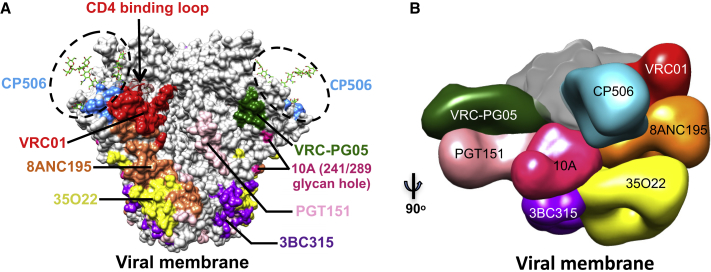
CP506 Lineage Antibody Epitopes on the Env Trimer(A) Epitopes of the CP506-lineage antibodies, representative bNAbs, and 241/289 glycan hole targeting mAb 10A on the BG505 SOSIP.664 trimer surface (PDB: 4TVP), with a side view of two protomers shown.(B) Binding site comparison of CP506 to selected bNAbs and 241/289 glycan hole targeting mAb 10A on 3D EM reconstruction in complex with the BG505 SOSIP.664 trimer. To simplify the view, only antibodies bound with one protomer are depicted.